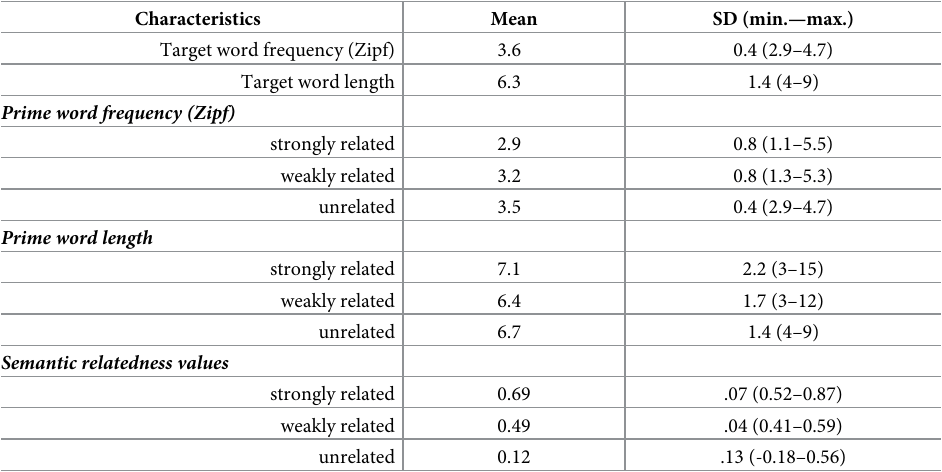
Table 1. Prime and target word characteristics of 264 word pair triplets: Length, word frequency (Zipf values [30]), and the semantic relatedness values (cosine similarity scores) for the strongly related, weakly related, and unrelated conditions tested in Survey 1 and Survey 2.